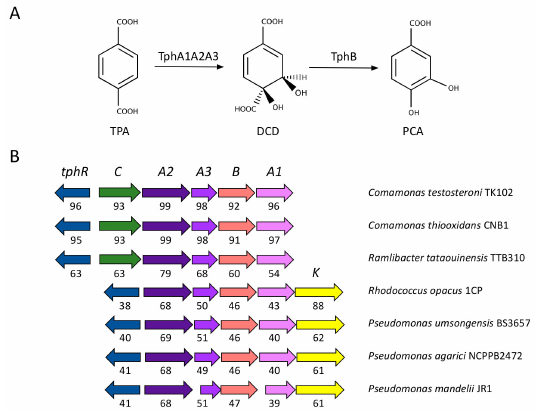
Figure 2. ( a ) TPA metabolism reported in bacteria. The names of the molecules and abbreviations are: terephthalic acid, TPA; 1,6-dihydroxycyclohexa-2,4-diene-dicarboxylate, DCD; protocatechuate, PCA. ( b ) Genetic organisation of the tph genes identified in several genomes available in databases. Numbers below arrows indicate the percentage of identity compared to the orthologous genes present in Comamonas sp. E6 (accession: AB238679; [50]) with the exception of the tphK genes that were compared to the ortholog present in the plasmid pDK3 of Rhodococcus sp. DK17 (accession: AY502076; [48]). Plots were produced with SyntTax (http: // archaea.u-psud.fr / SyntTax; [55]).